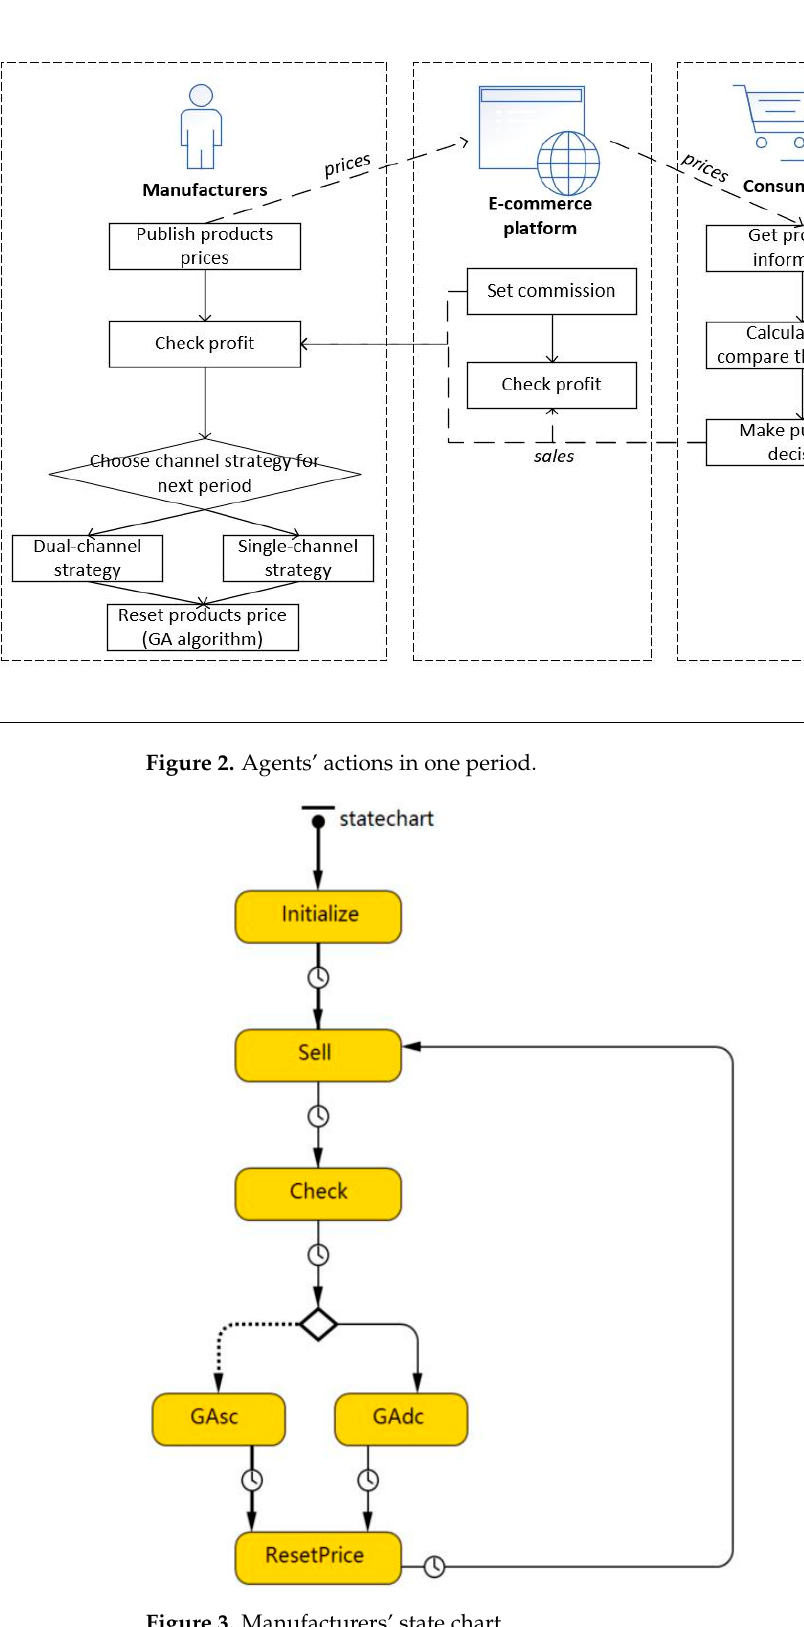
Figure 3. Manufacturers’ state chart.